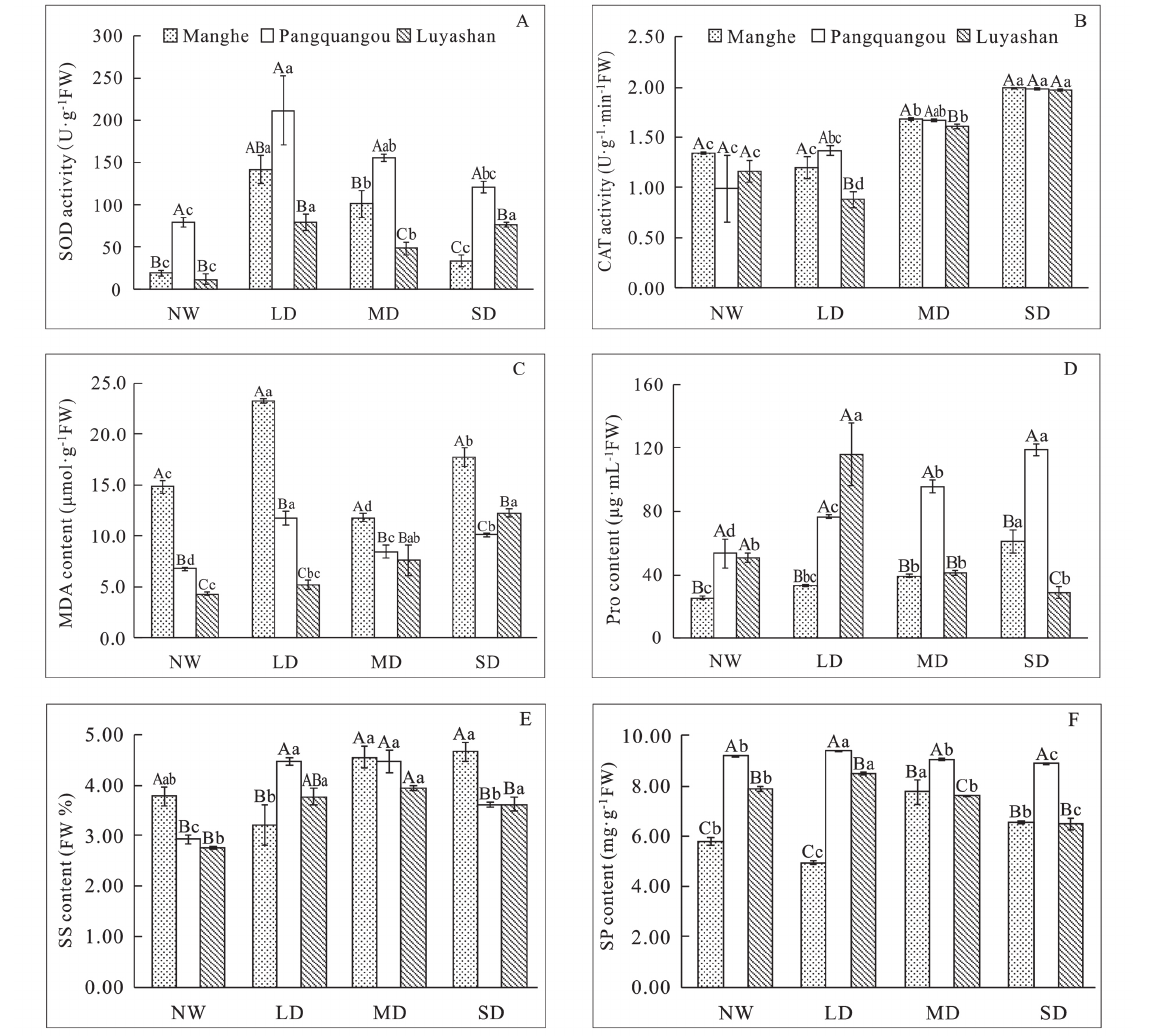
Fig. 5: Antioxidant-response and osmotic-regulation indexes of three provenances of Dioscorea nipponica Makino treated by four water regimes. Three antioxidant-response indexes included superoxide dismutase (SOD, U·g -1 FW), catalase (CAT, U·g -1 ·min -1 FW) and malondialdehyde (MDA, μmol·g -1 FW). Three osmotic substances included proline (Pro, μg·mL -1 FW), soluble sugar (SS, FW%) and soluble protein (SP, mg·g -1 FW). Three provenances involved Manghe, Pangquangou and Luyashan. Four water regimes involved normal-watered (NW, 70%-85% water holding capacity, WHC), light drought stress (LD, 55%-60% WHC), moderate drought stress (MD, 40%-45% WHC) and severe drought stress (SD, 20%-35% WHC). Different capital letters indicate significant difference among three provenances at P < 0.05; Different lower-case letters indicate significant difference among four water regimes at P <